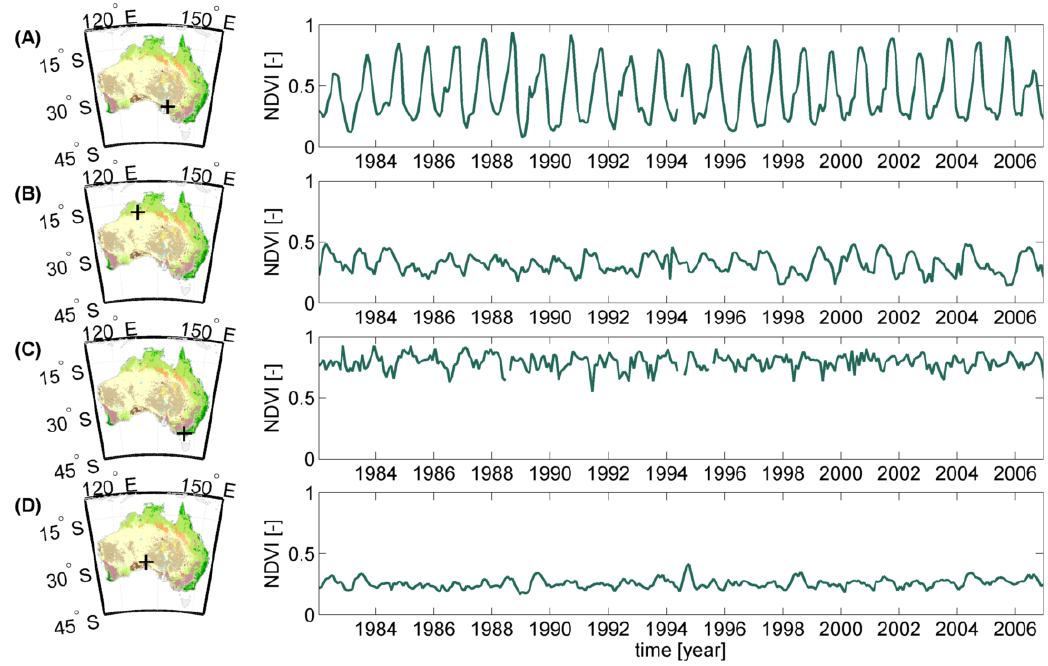
Figure 2. Proof of concept: Illustration of the variety of vegetation dynamics in Australia. ( A ) Sinusoidal winter (e.g., southeastern crop lands); ( B ) sinusoidal summer (e.g., northern woodlands); ( C ) forests; and ( D ) arid lands. The left panel illustrates the location for which the NDVI time series in the right panel is